Question: Summarize what this figure shows in one sentence.
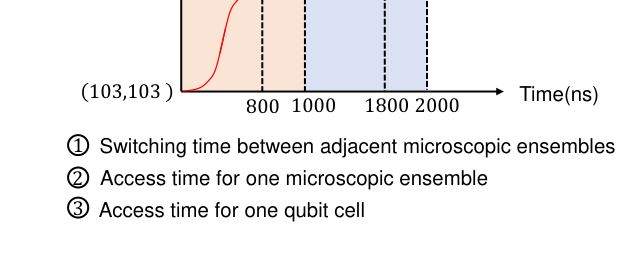
Answer: Storage of a time-bin qubit into two adjacent microscopic ensembles. (a) The schematic for AOD addressing. The RF signals are generated by the arbitrary waveform generators and go through a switch and an amplifier to drive the AOD. (b) The move of the AOD addressing point as RF signals of different frequencies are fed into the AOD. Every time we visit a microscopic ensemble, the AOD addressing point keeps stationary for 200 ns. During the 200 ns, the EIT process happens and the photons are stored in or retrieved from the memory.